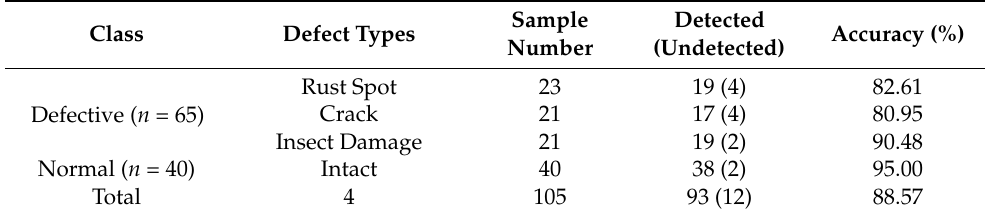
Table 5. Test results by applying the developed algorithm to 105 independent samples with different defect